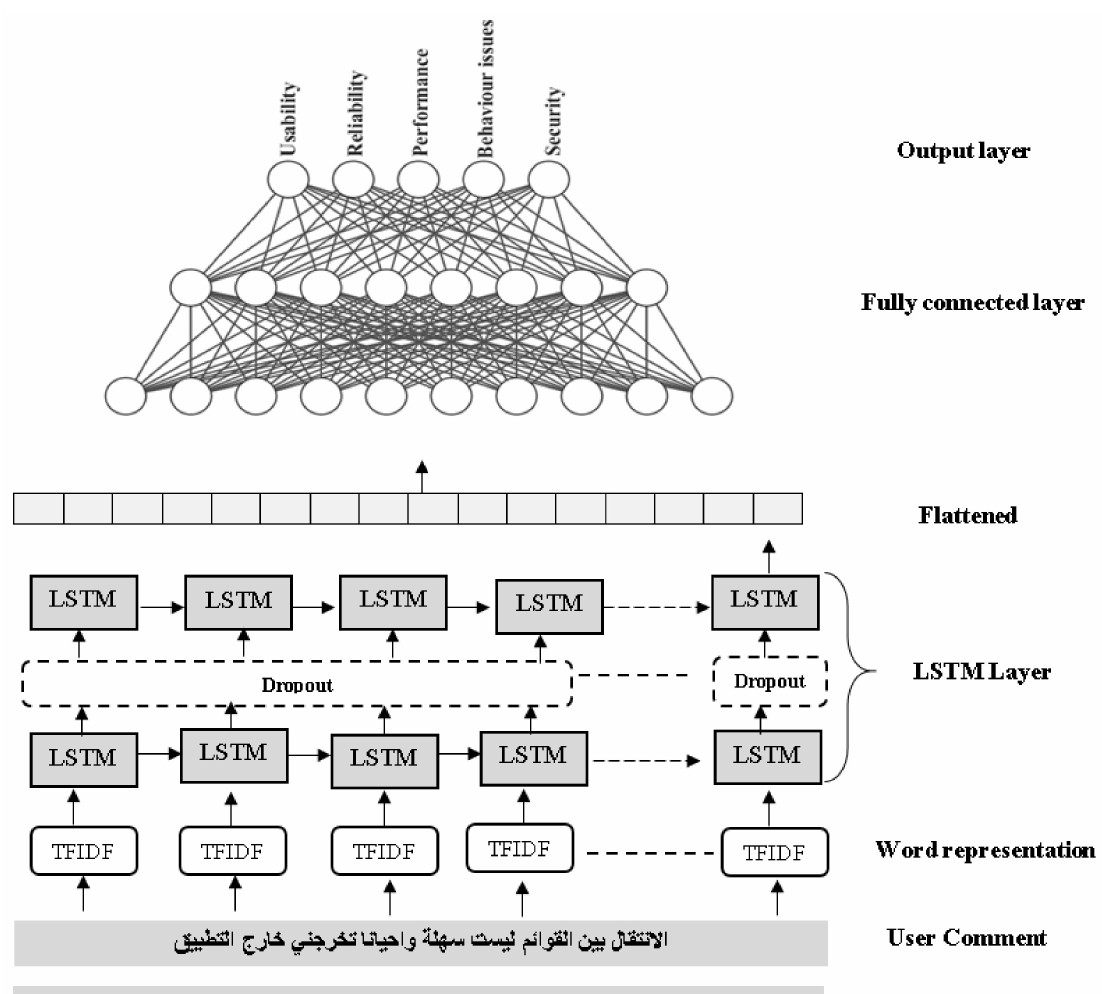
Figure 3. LSTM model